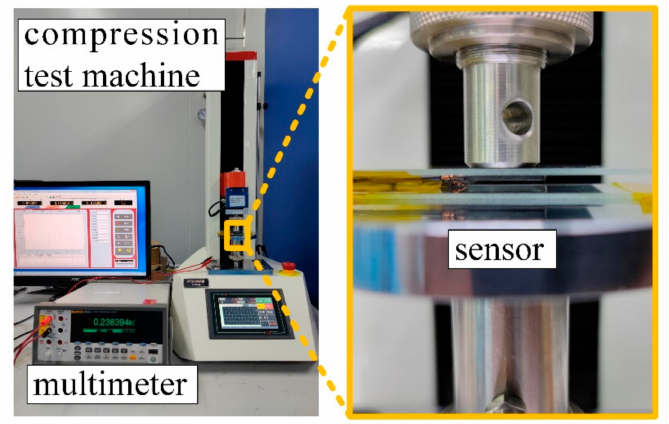
Figure 8. Experimental